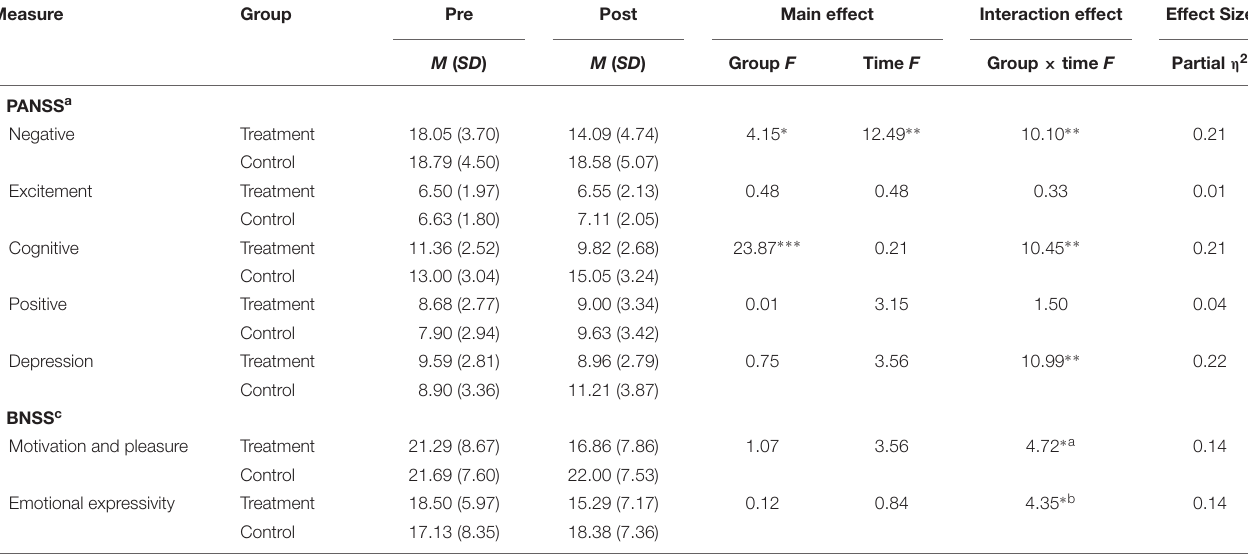
TABLE 2 | Effects of mBA on psychiatric